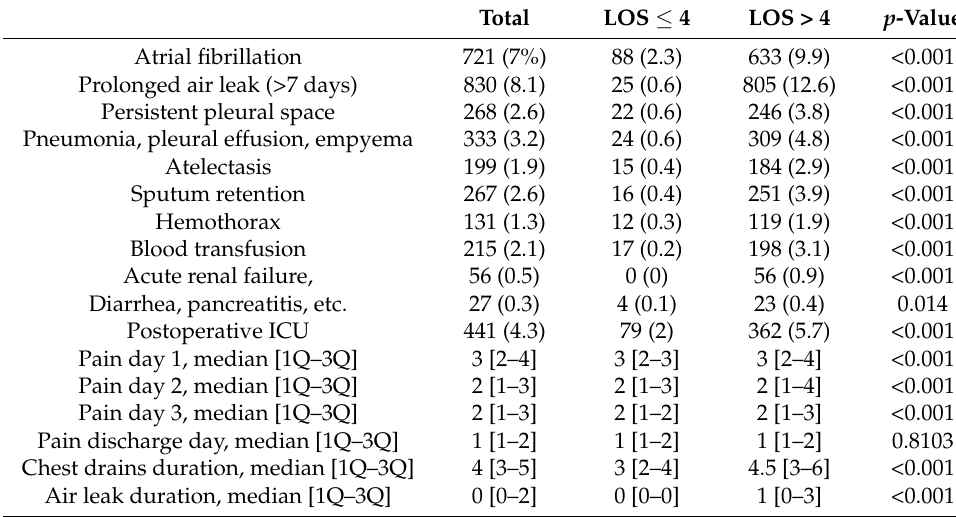
Table 6. Patients’ postoperative events.